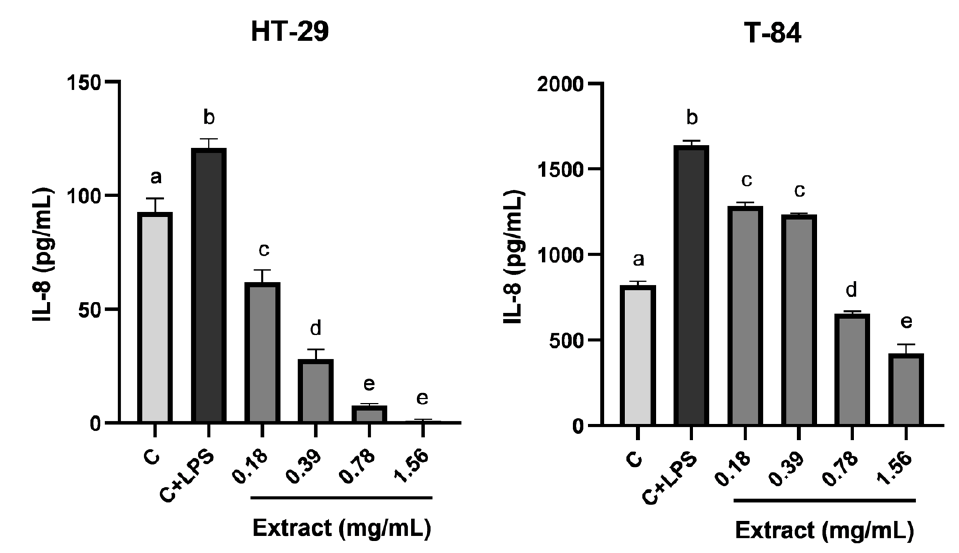
Figure 2. Effect of blackberry extract on levels of IL-8 produced by HT-29 and T-84 cells stimulated with LPS. Cells were induced during 24 h with LPS (1 μg/mL) and increasing concentrations of bilberry leaves extract (0.18-1.56 mg/mL). C: cells not induced with LPS (Control); C+LPS: cells induced with just LPS (1 μg/mL). The experiments were performed in triplicate. Groups with different letters are significantly different ( p < 0.05).